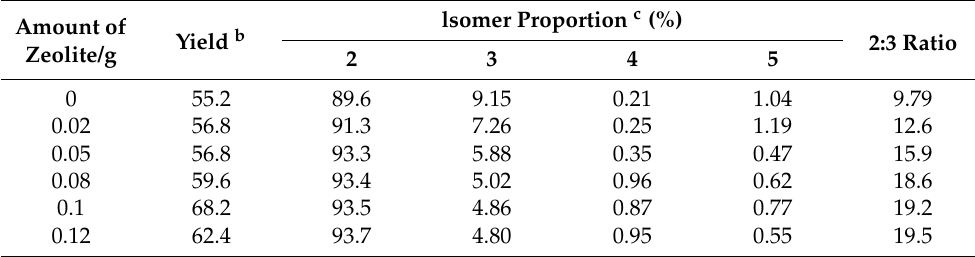
Table 5. Effect of different amounts of HBEA-25 a . Amount